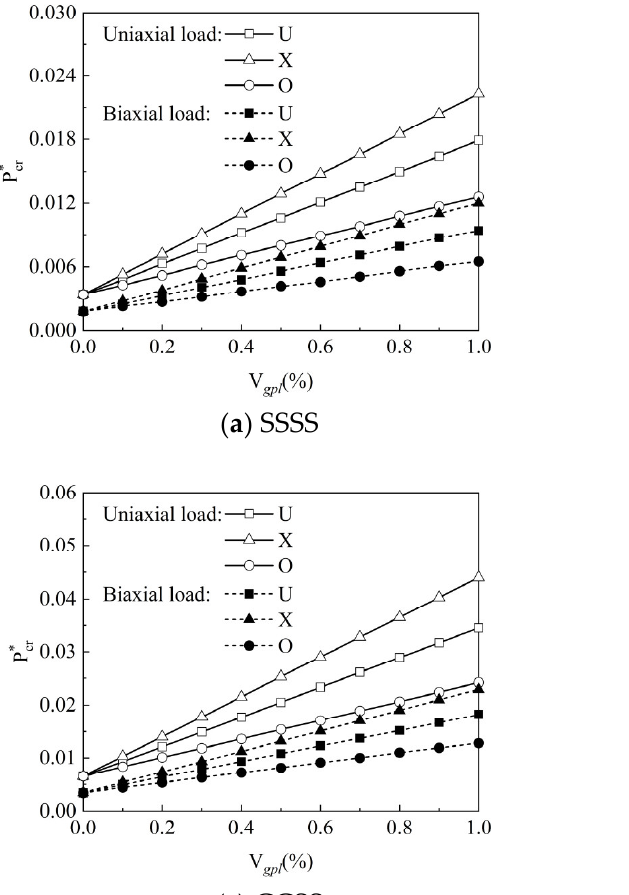
Figure 13. Variation of dimensionless critical buckling load along the elastic coefficient of the Win- kler elastic foundation for an SSSS FG-GRP plate. 5. Conclusions Isogeometric analysis integrated with the refined plate theory is utilized in this paper to analyze the static bending, free vibration and buckling behaviors of functionally graded graphene-platelet-reinforced piezoelectric plates on Winkler elastic foundations. When Hamilton’s principle is combined with isogeometric analysis, the isogeometric finite ele- ment governing equations of the functionally graded graphene-platelet-reinforced piezo- electric plate are obtained on the basis of the refined plate theory. Comparisons with other studies validate the accuracy and convergence of the present isogeometric analysis. Fur- thermore, the influences of a plate’s geometrical parameters, the elastic coefficient, and GPLs’ physical and geometric properties on the percentage change of central deflections, frequencies and critical buckling loads of a functionally graded graphene-platelet-rein- forced piezoelectric plate are thoroughly investigated under different boundary condi- tions and graphene distribution patterns. The results of this paper indicate that adding a small amount of GPL not only de- creases the central deflections, but also increases the vibration frequencies and critical buckling loads of functionally graded graphene-platelet-reinforced piezoelectric plates. Additionally, the X type represents the optimum distribution form, i.e., the higher the graphene volume fractions spread into the surface layer, the more effective it is to enhance the stiffness of the system. Additionally, increasing the graphene length-to-thickness ratio can significantly enhance system stiffness, that is, the longer and thinner the GPLs are, the more obvious the reinforcement is. In terms of a plate’s geometrical parameters, the effect of a functionally graded graphene-platelet-reinforced piezoelectric plate’s aspect ratio on